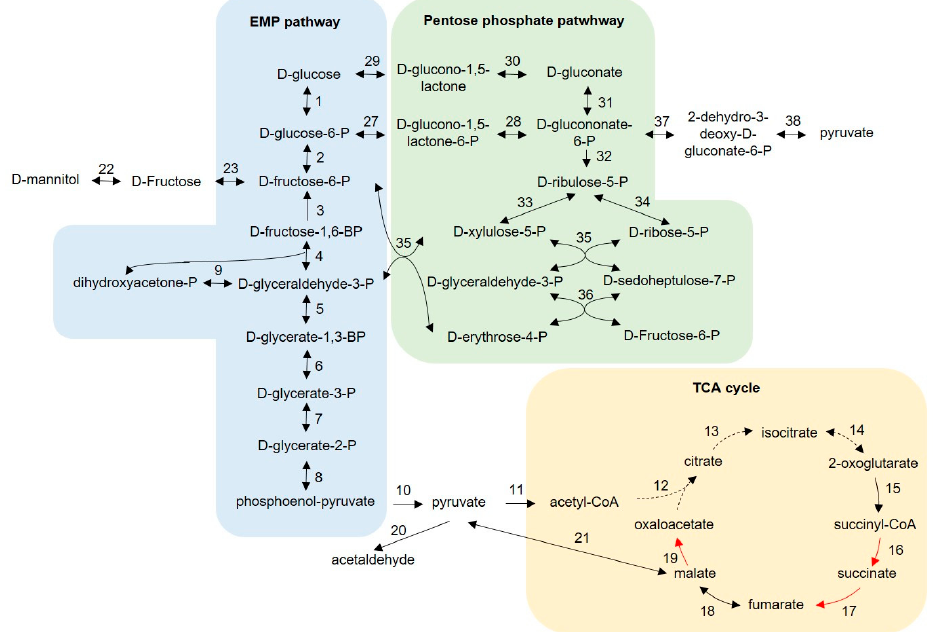
Figure 3. Predicted cytoplasmic carbohydrate metabolism of Bombella spp. (based on [19,45]). Dashed arrows indicate genes not present in all genomes. Red arrows indicate missing genes. Locus